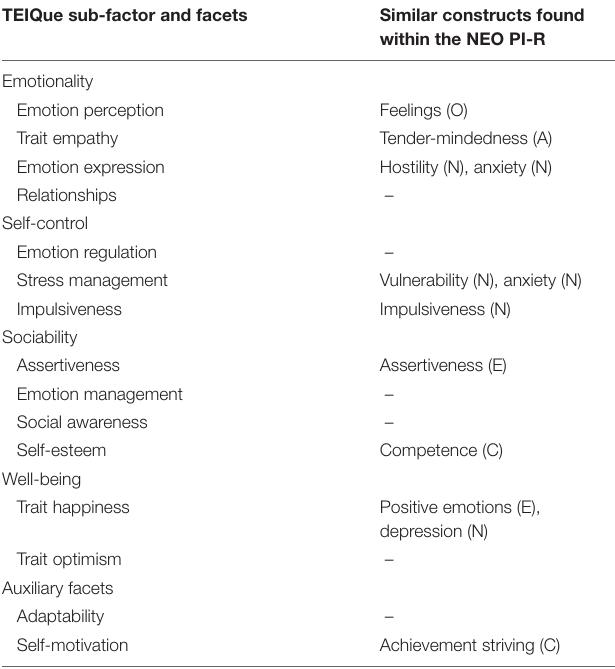
TABLE 1 | TEIQue facets and similarities to the Big